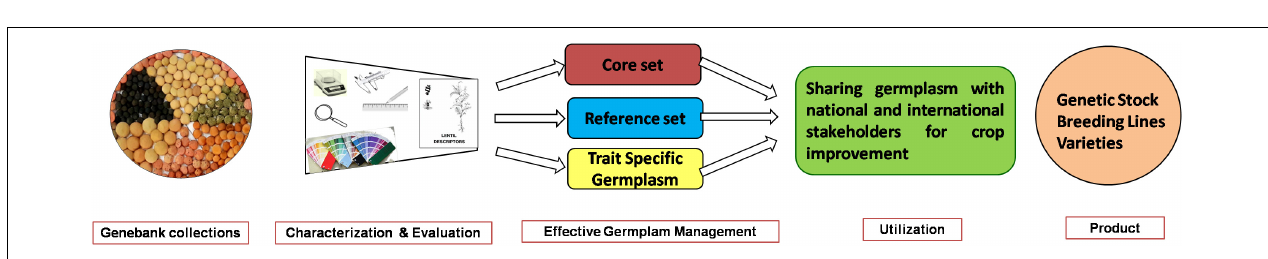
FIGURE 10 | Scatter plot matrix showing the correlation between nine agro-morphological traits of the Indian national genebank lentil core set.